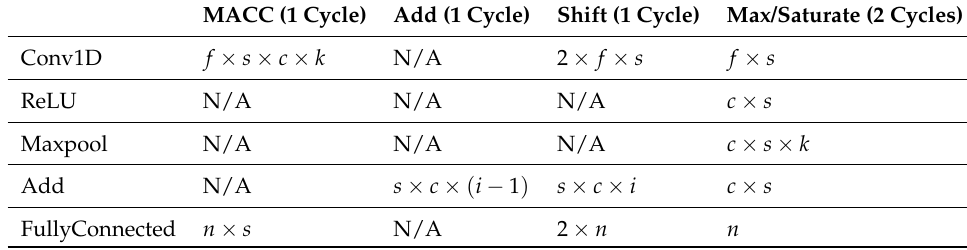
Table A6. Number of arithmetic and logic operations with fixed-point on integers inference for the main layers of a residual neural network with f the number of filters (output channels), s the number of input samples, c the number of input channels, k the kernel size, n the number of neurons and i the number of input layers to the residual Add layer. Conv1D is assumed to be without padding and with a stride of